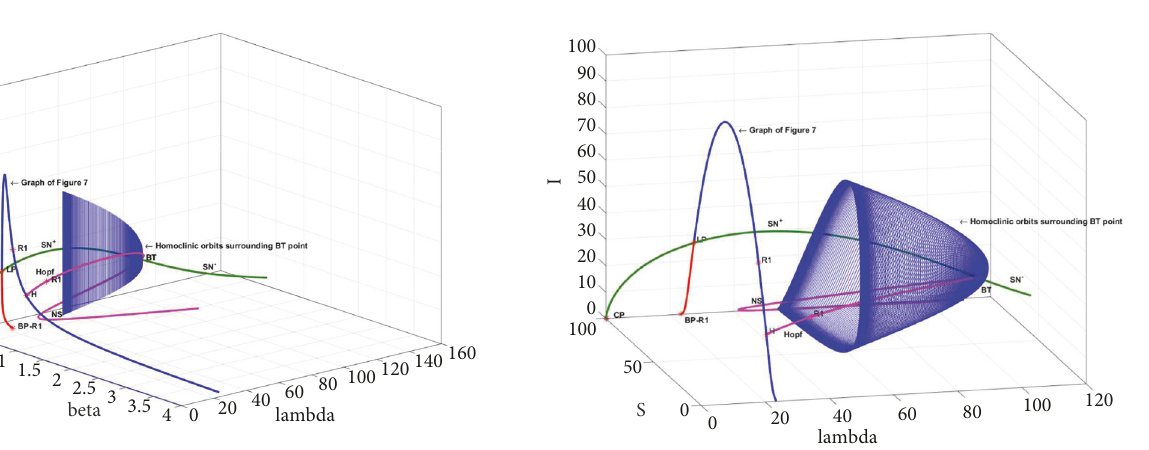
Figure 14: Bifurcation diagram in the (𝜆,𝑆, 𝐼) space showing the homoclinic orbits that emerge from the Bogdanov-Takens